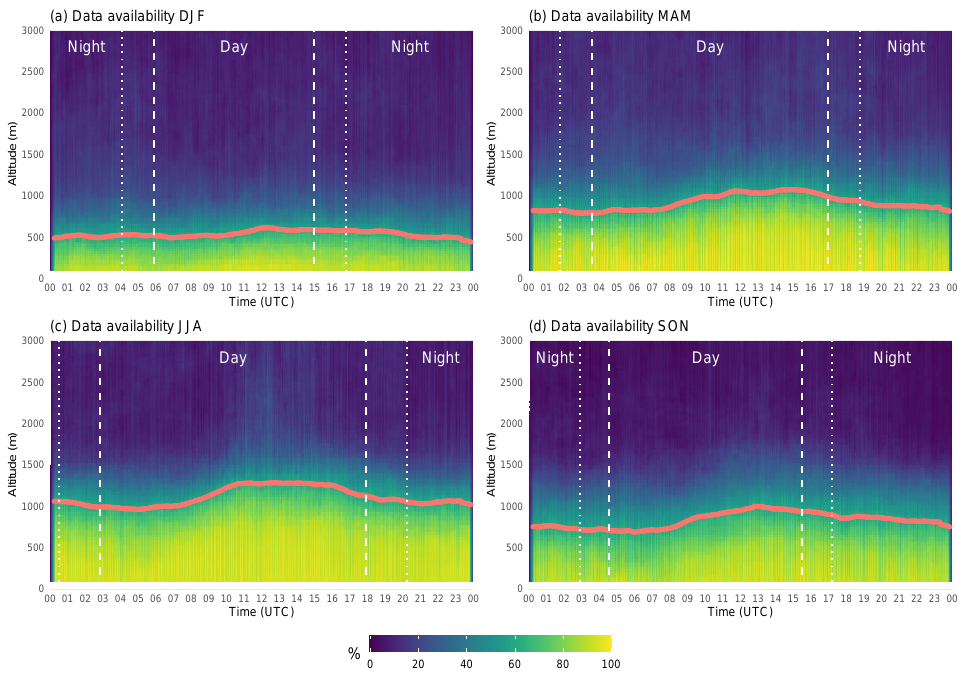
Figure 4. Data availability for Bucharest–M˘agurele station between December 2019 and November 2021 period. Red lines show the altitudes where data availability drops below 60%. The time of the sunrise start, sunrise end (dashed white lines), sunset start, and the sunset end (dotted white lines) are also